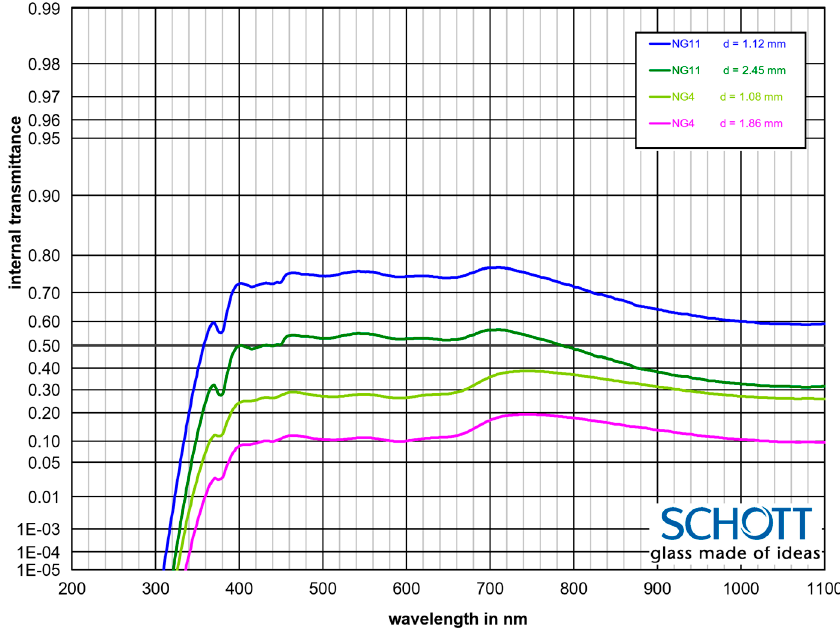
Figure 6. Internal transmittance of the calibration filters, calculated with a tool provided by the manufacturer (https://www.schott.com/advanced_optics/).